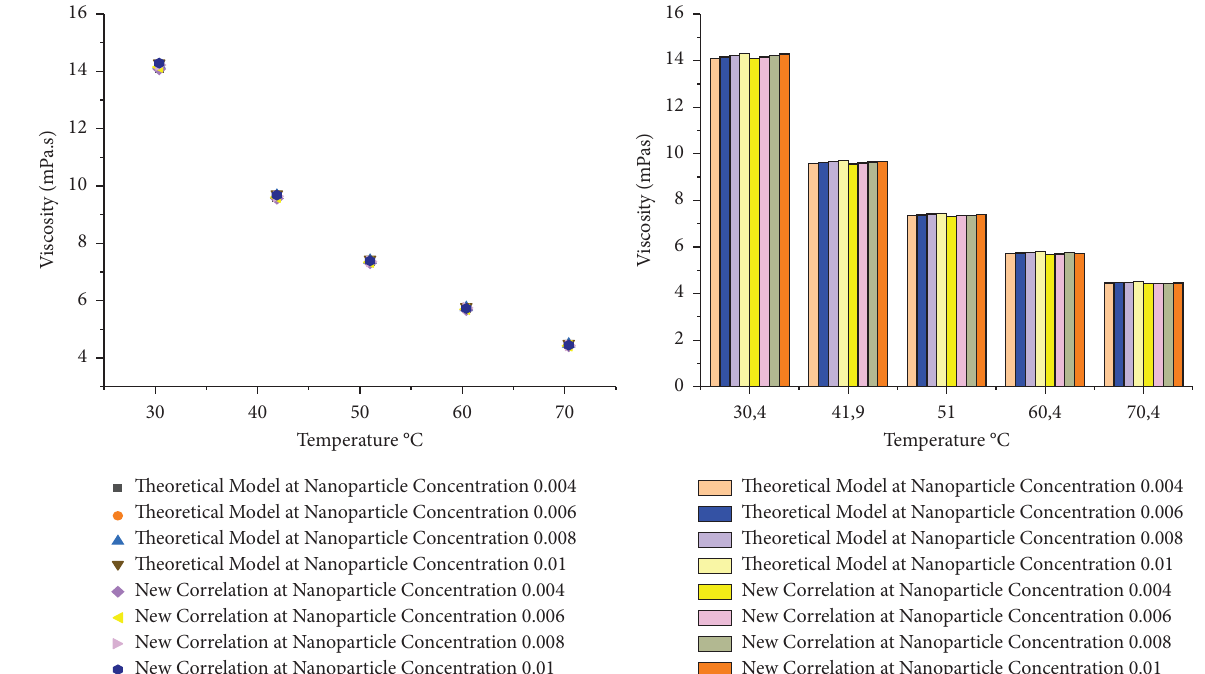
Figure 2: Comparison of titanium oxide-ethylene glycol nanofuid viscosity theoretical model and new